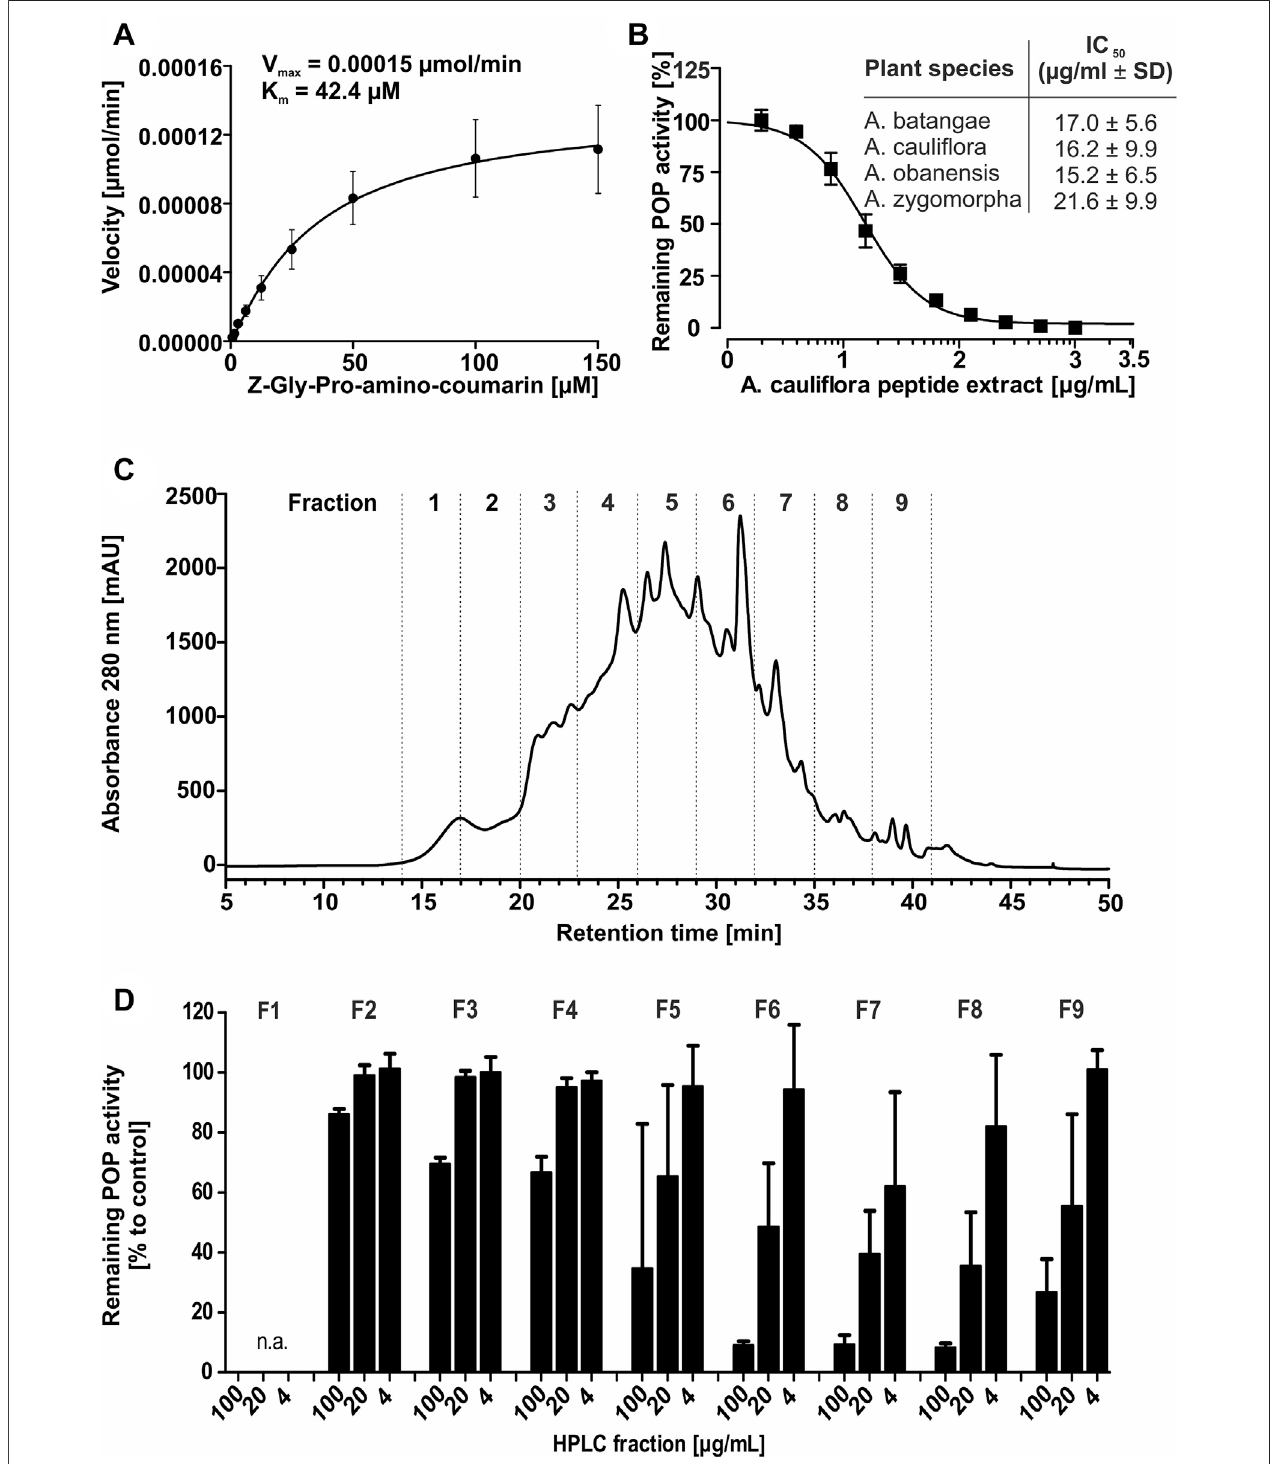
FIGURE 3 | Bioassay-guided isolation of prolyl oligopeptidase inhibitors. A Michaelis-Menten kinetics were measured to ensure the quality of the recombinant enzyme; this yielded K m (42.4 µM) and V max (0.00015 µmol AMC min) using the optimized POP enzyme inhibition assay conditions (A). The inhibition activity of peptide enriched plant extracts derived from four specimen of the Allexis tribe towards human POP was evaluated in a dose concentration-response study applying 2 – 1,000 μ g/ml. For A. cauli fl ora the concentration-response curve is shown. The table lists obtained IC 50 values for the four A. cauli fl ora (IC 50 16.2 ±